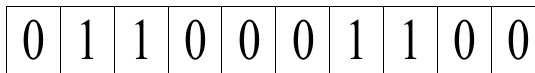
Figure 3. Chromosome coding mode.